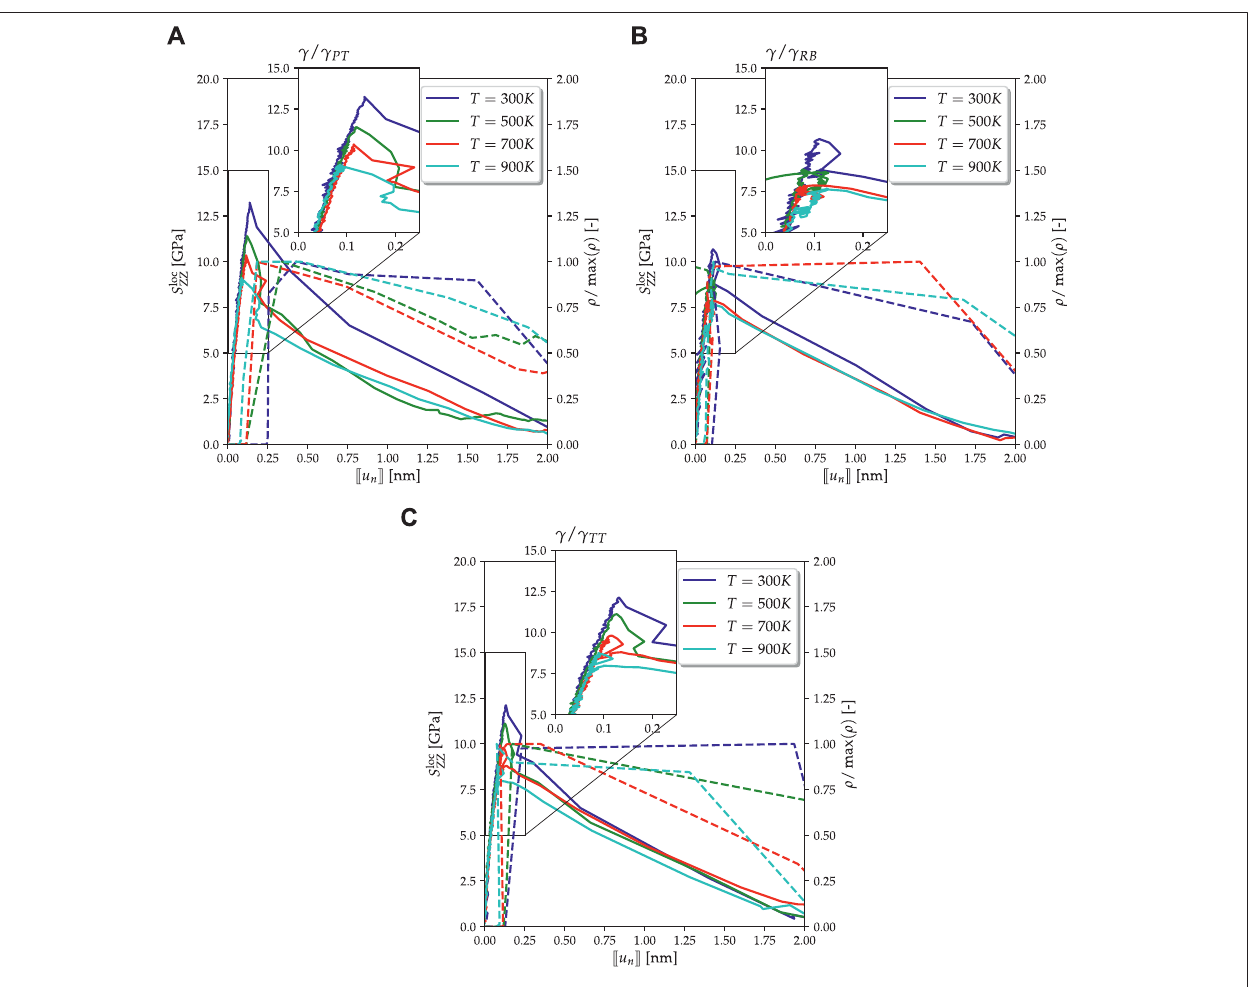
FIGURE 6 | Traction – separation curves (solid lines) from MD simulations with strain rate _ ε glo ZZ (cid:2) 10 9 / s for different temperatures and Type-1 models of three c / c interfaces(i.e., (A) c / c PT , (B) c / c RB ,and (C) c / c TT ).Theevolutionofthedislocationdensityisillustratedbythedashedlines.Theinset fi guresshowthetraction – separation curves in the yielding regime in greater